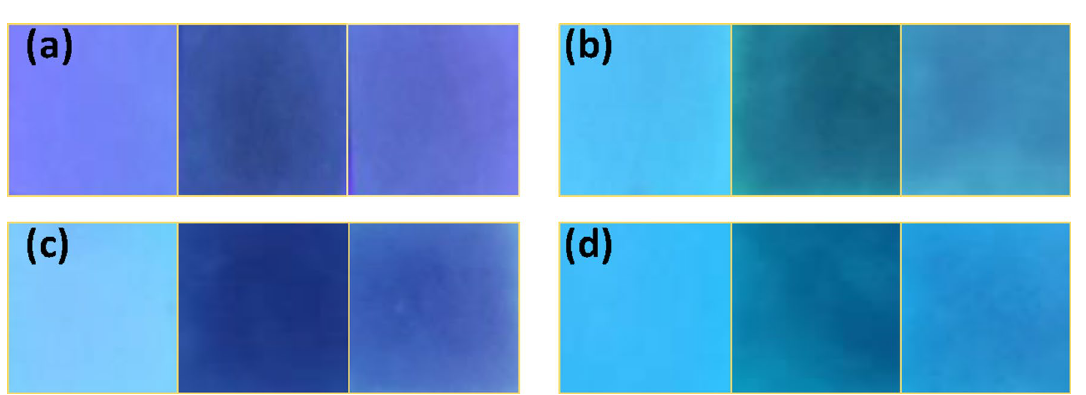
Figure 7. Paper strip images of compounds 1 – 4 after the addition of different concentrations of PA. (0 M, 10 −3 M, 10 −11